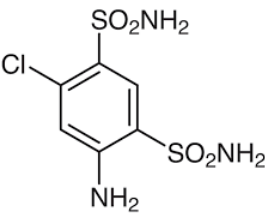
Processes 2022 , 10 , x FOR PEER REVIEW Figure 13. Chemical structure of Hydrochlorothiazide. Figure 13. Chemical structure of Hydrochlorothiazide. Figure 13. Chemical structure of Hydrochlorothiazide.